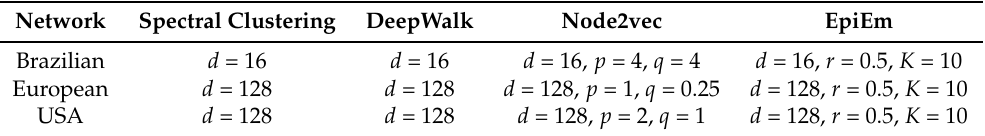
Table 1. Parameter settings for different